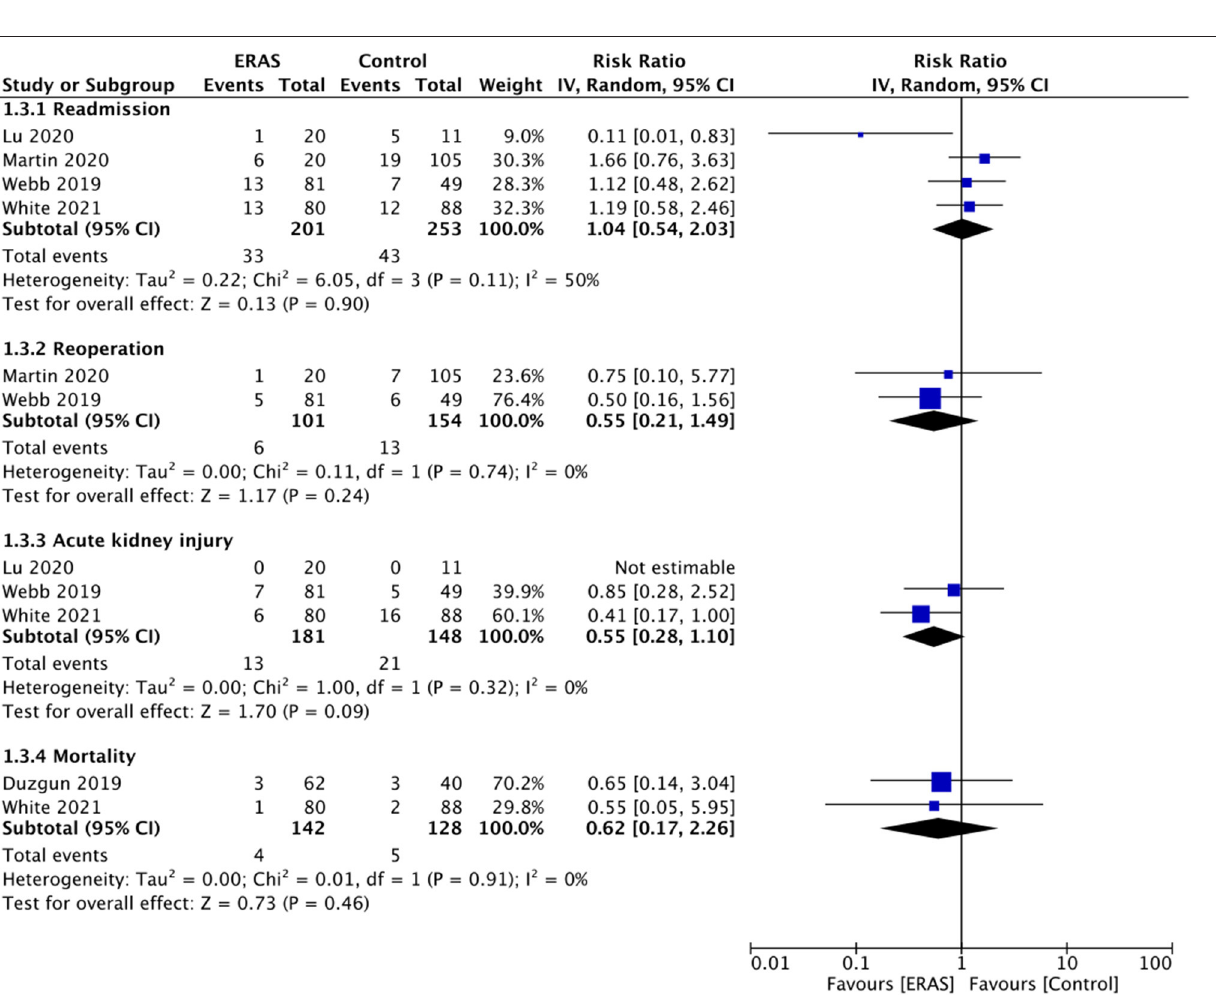
FIGURE 3 | Meta-analysis for grade III/IV complications between ERAS and control groups.